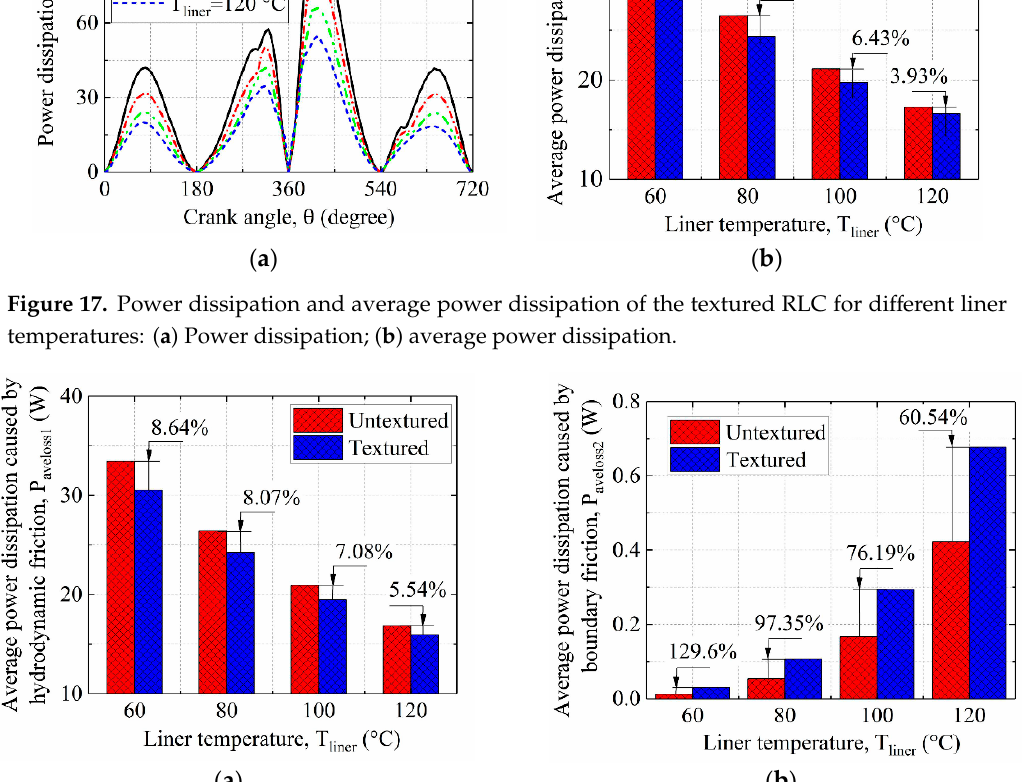
for di ff erent liner temperatures: ( a ) Average power dissipation caused by the hydrodynamic friction; different liner temperatures : ( a ) Average power dissipation caused by the hydrodynamic friction; ( b )